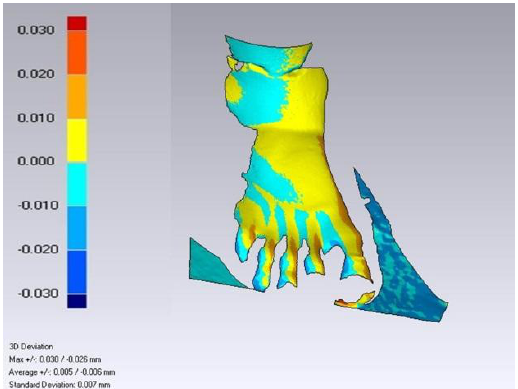
Figure 1. 3D comparion of TLS and LS registered data.